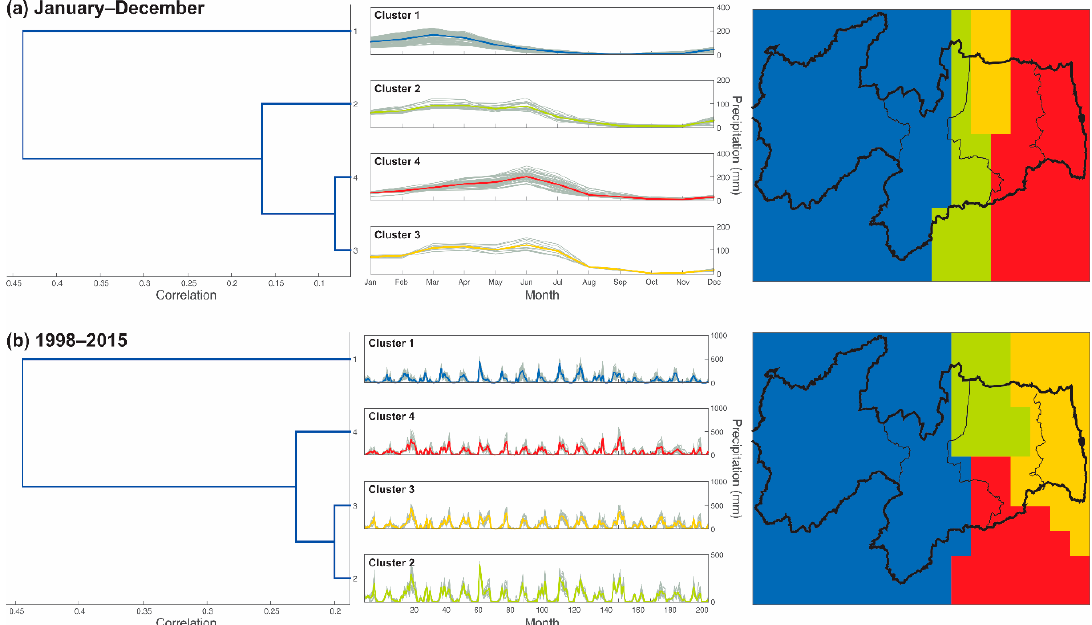
Figure 5. Dendrograms and cluster spatializations in four clusters based on ( a ) the mean monthly precipitation time series and ( b ) total monthly precipitation time series, for the analyzed period (1998–2015). On the left are the dendrograms. In the center are the hyetographs. On the right are the cluster spatial distributions.